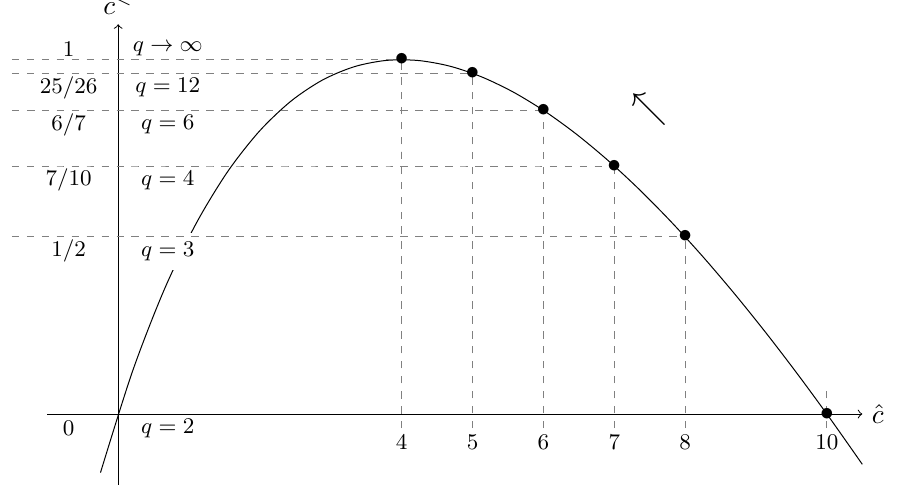
Figure 1 . Hidden small central charge c < vs. ^ c . Integer values of ^ c in the - sequence compatible with unitarity are identi(cid:12)ed with (cid:15)